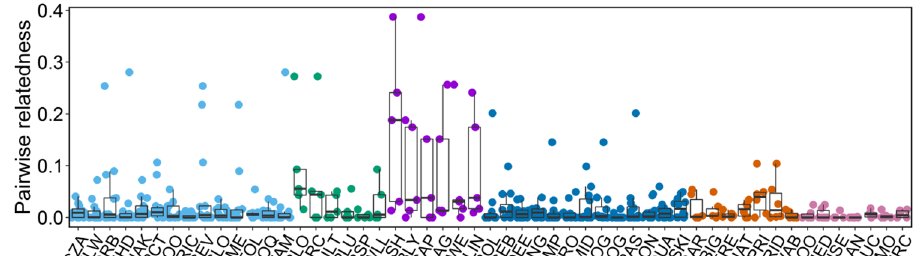
Figure 4. Distribution of relatedness values of 53 males to their second-order alliance members used in the first-order GLMM, which represent their available pool of males from whom to form first-order alliances. Individual data points indicating relatedness between the 53 males and their second-order alliance members are provided as filled circles, with colours representing second-order alliance